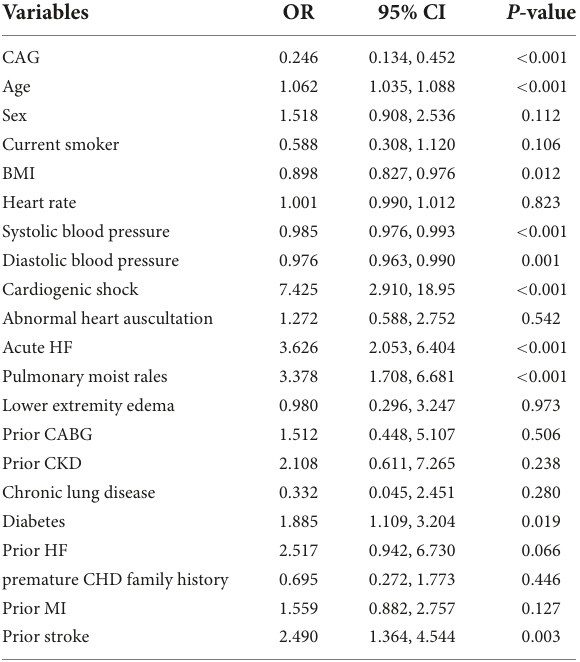
TABLE 4 Univariate analysis of the rate of MACEs of NSTEMI patients.